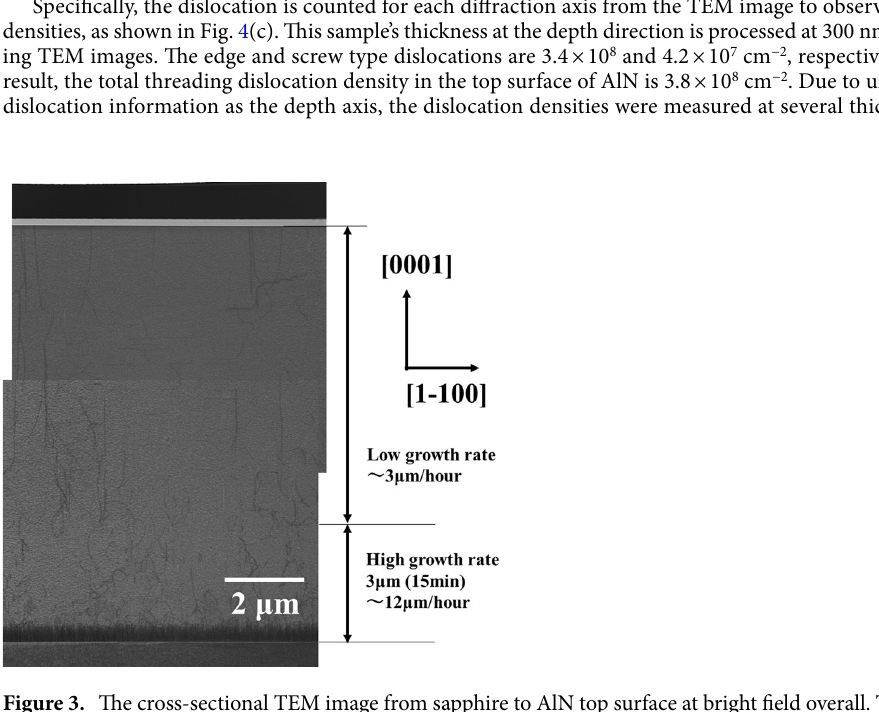
Figure 3. The cross-sectional TEM image from sapphire to AlN top surface at bright field overall. The depth and width sizes are 300 nm and 7.9 μm, respectively, in each picture. From the sapphire, the initial 3 μm and from that until the surface are different growth conditions at the high and low growth